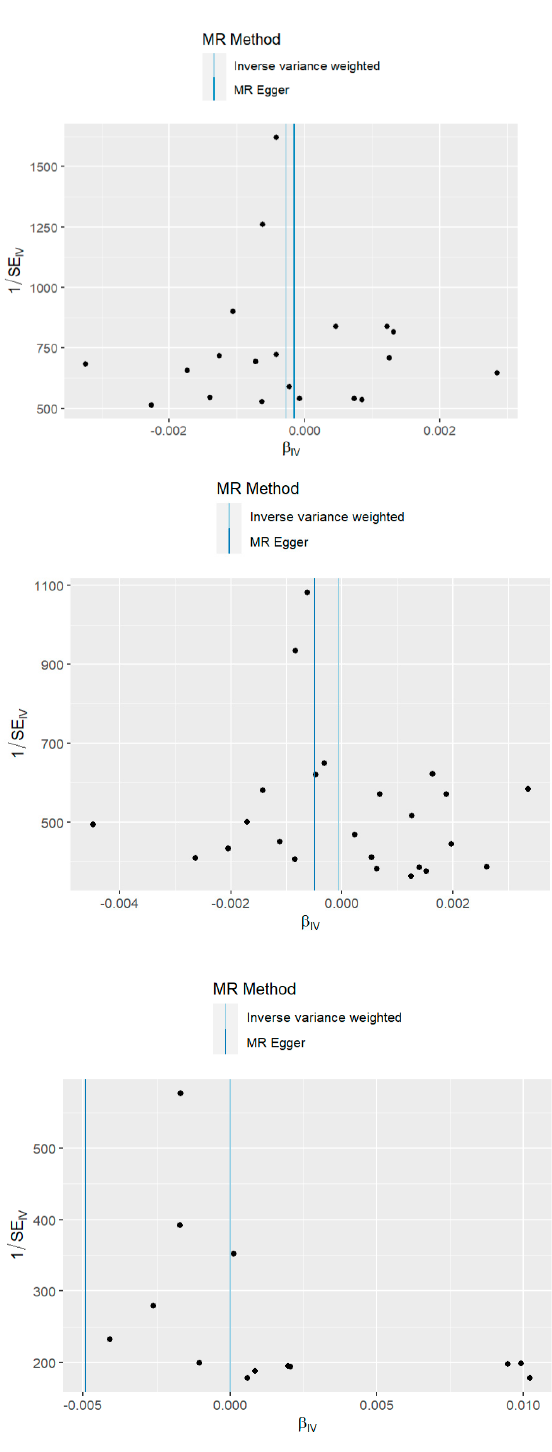
Figure 4. Funnel plots of TSMR Results: severity, hospitalization, and susceptibility.